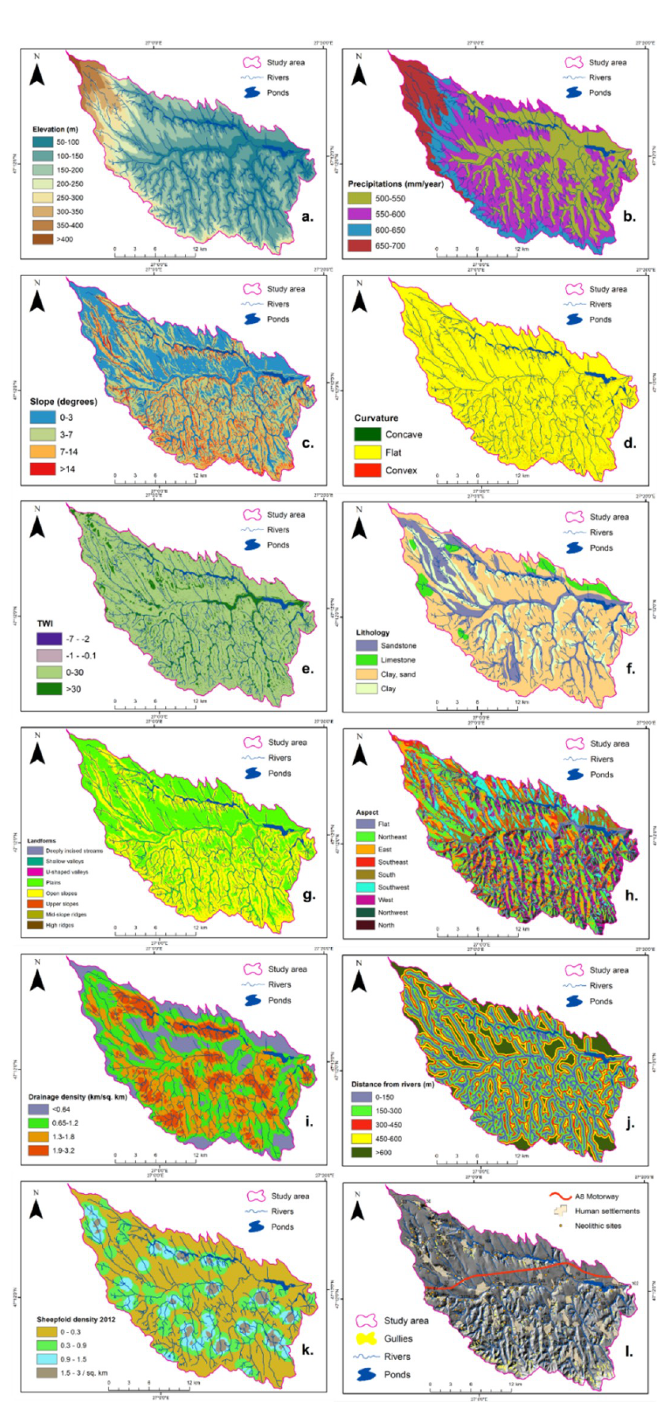
Figure 4. Gully erosion conditioning factors and classification. ( a ) Elevation, ( b ) precipitations, ( c ) slope angle, ( d ) curvature, ( e ) topographic wetness index (TWI), ( f ) lithology, ( g ) landforms, ( h ) aspect, ( i ) drainage density, ( j ) distance from rivers, ( k ) sheepfold density, ( l ) future location of the A8 Motorway.